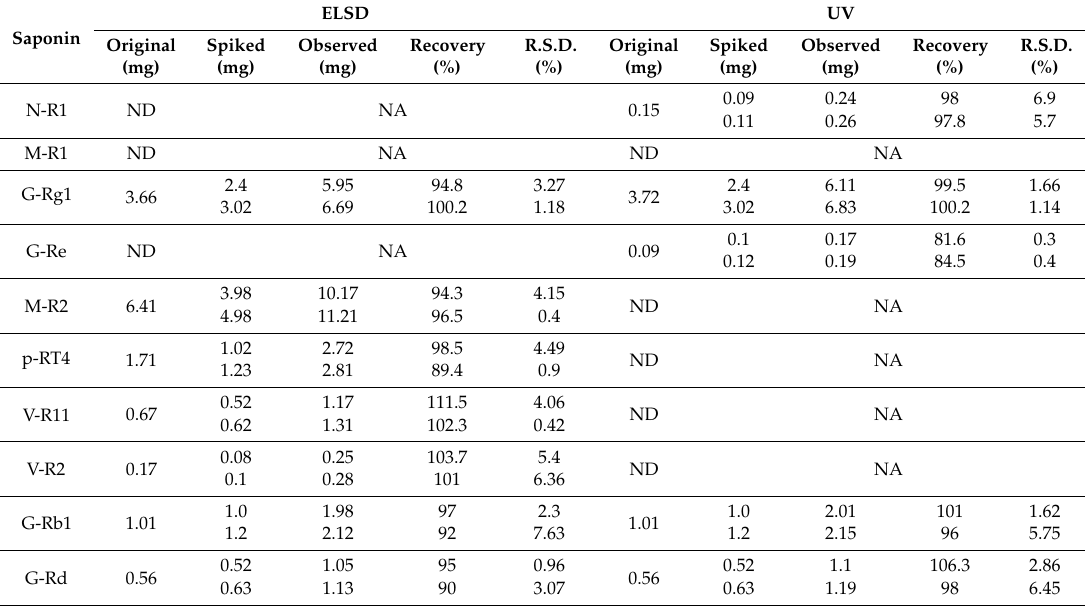
Table 3. Accuracy of the HPLC-ELSD-UV method for the determination of saponins in PV. ELSD UV Saponin Original Spiked Observed (mg) (mg)